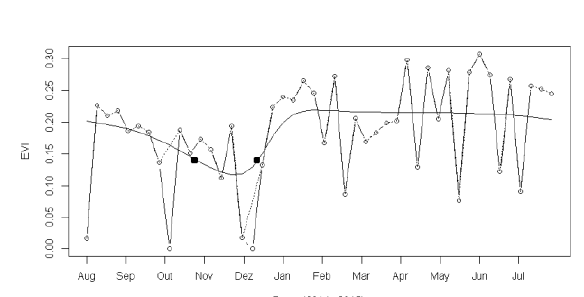
Figure 8. Time series EVI spectral profile for a planted forest sample of eucalyptus.